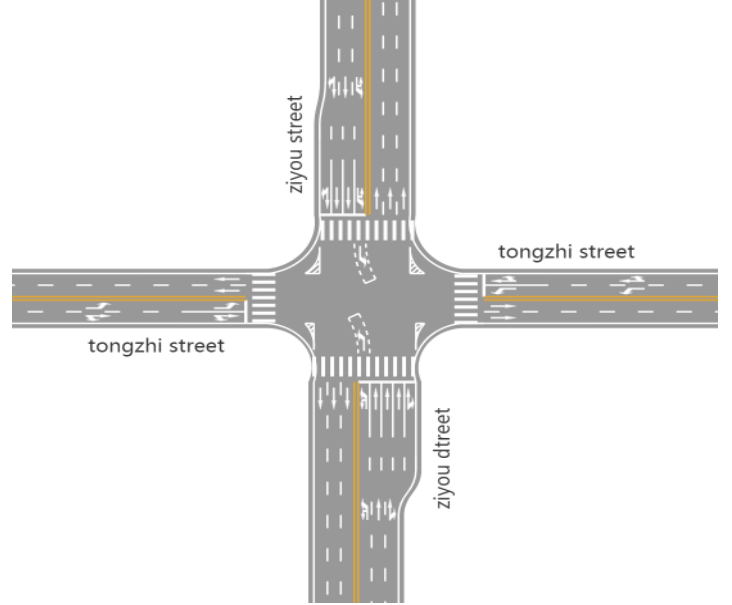
Figure 6. Sample diagram of intersection.